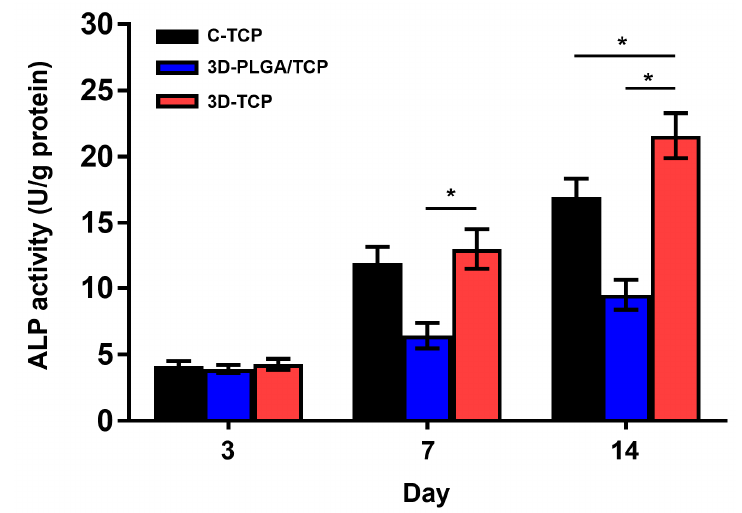
Figure 7. The effect of C-TCP, 3D-PLGA / TCP, and 3D-TCP scaffolds on ALP activity. The 3D interconnected structure and β -TCP amount enhanced the ALP activity on day 3, 7, and 14 (* p <